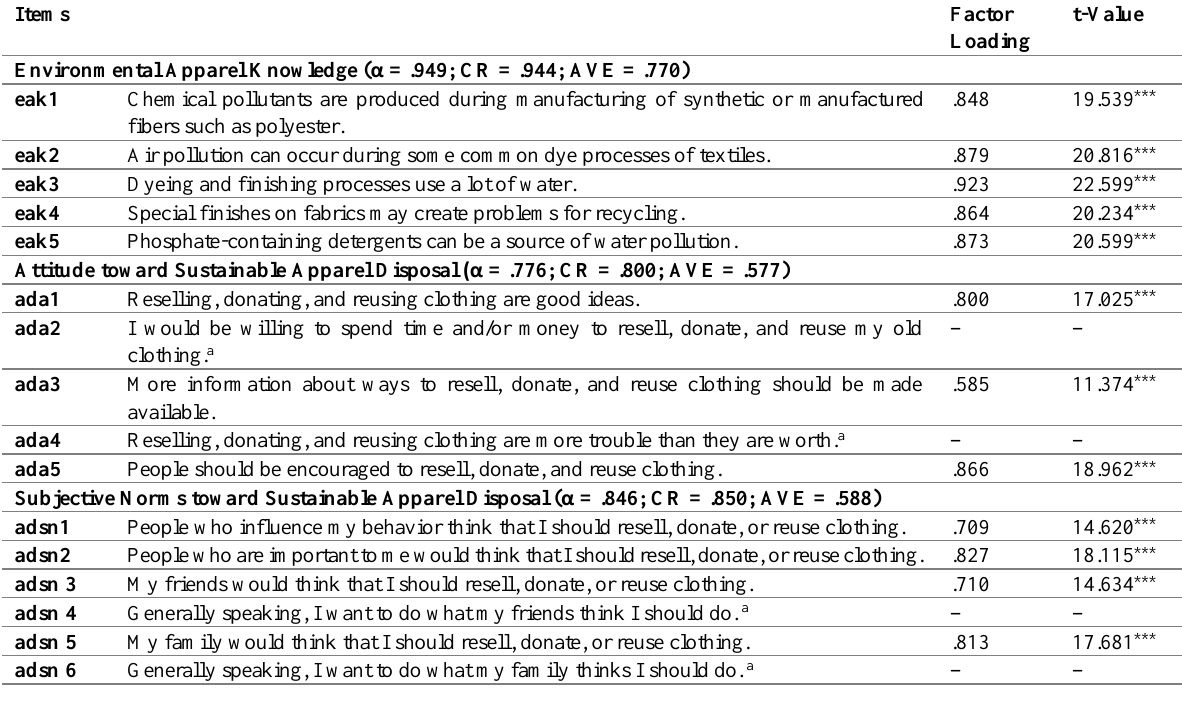
Table 1: Results of the Measurement